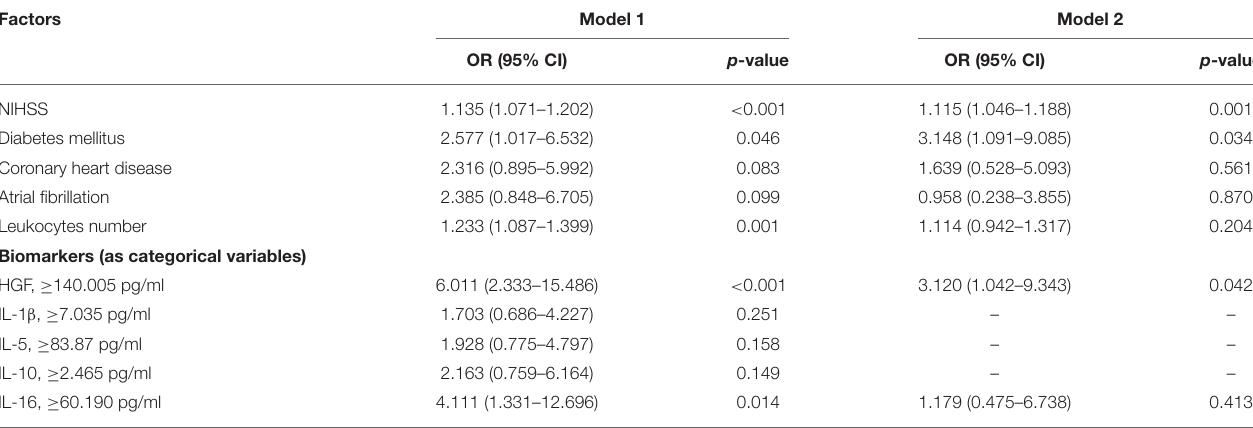
TABLE 4 | Biomarkers and risk of the secondary outcome after AIS.